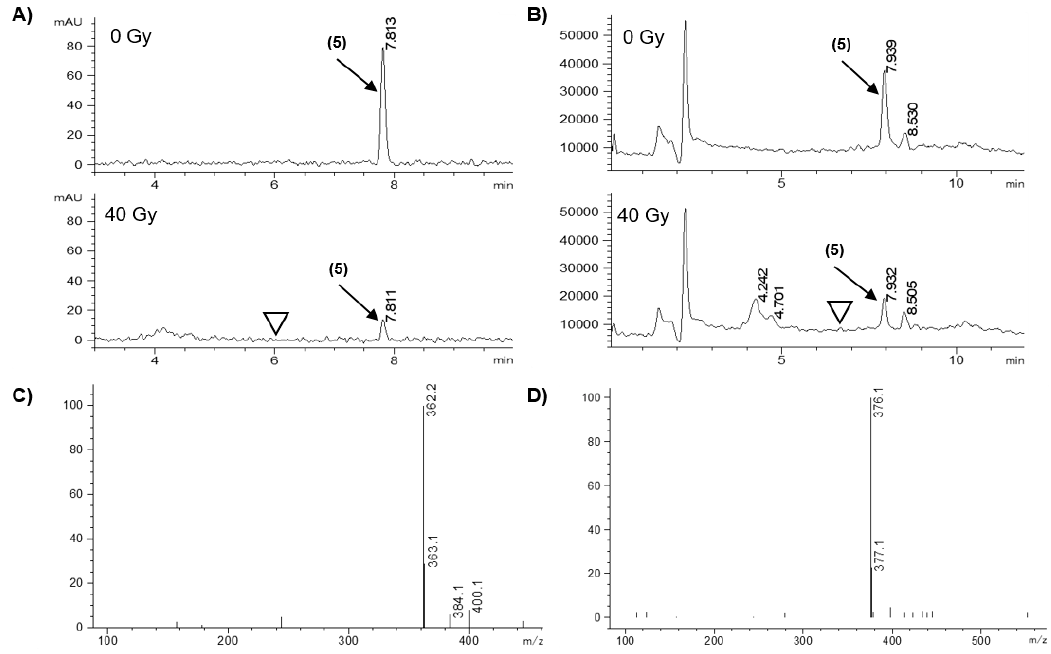
Table 2. Summary of radiolytic reduction results for immediate analysis following 40 Gy irradiation in anoxic formate buffer.